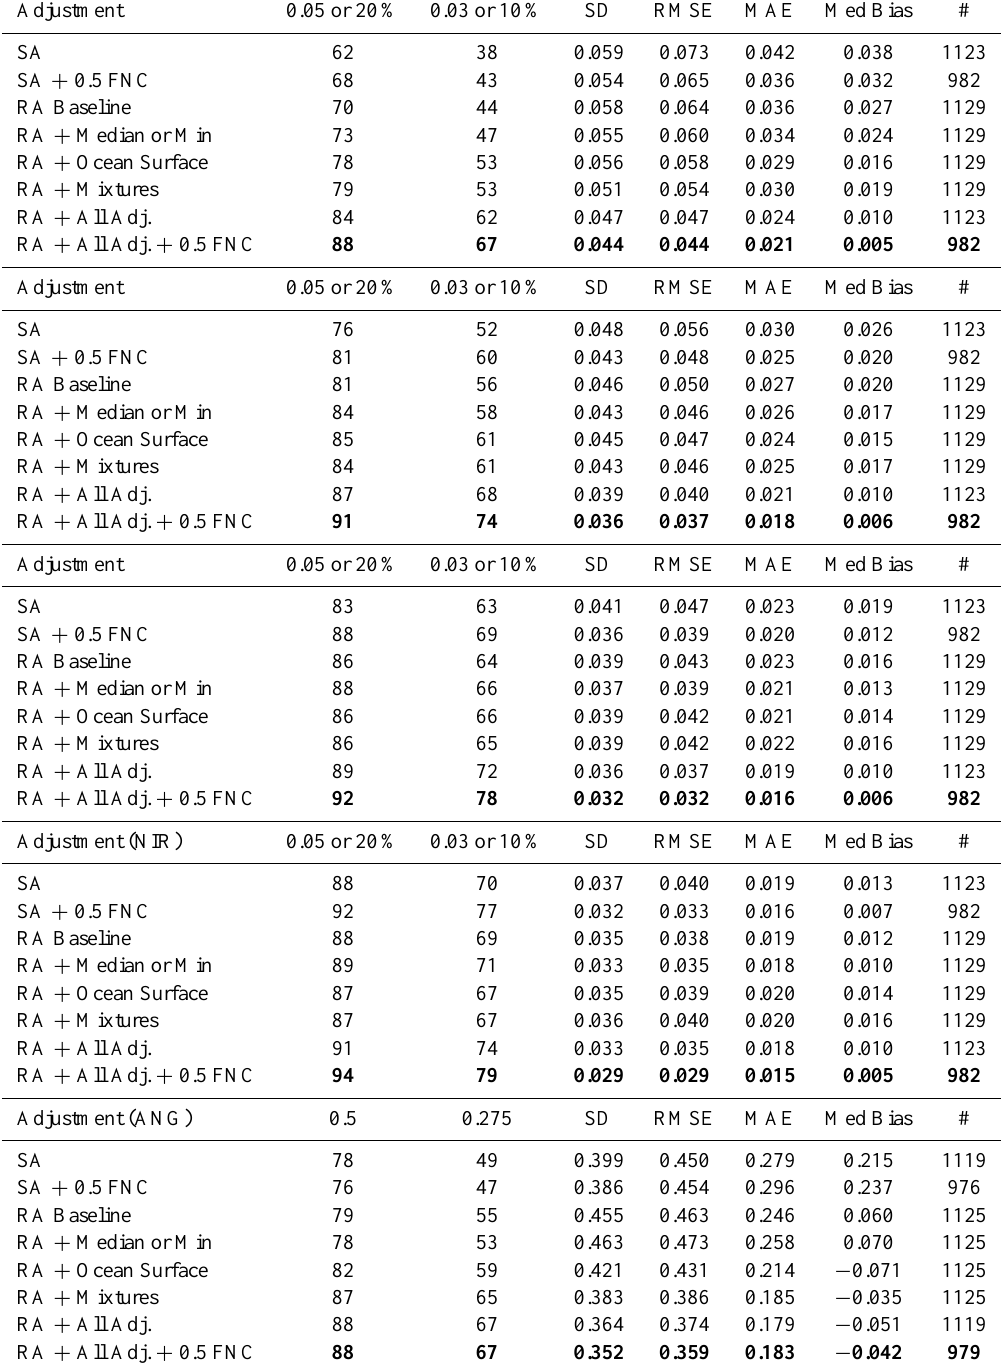
Table 3. Statistics of AOD and ANG retrievals stratified by adjustment ∗